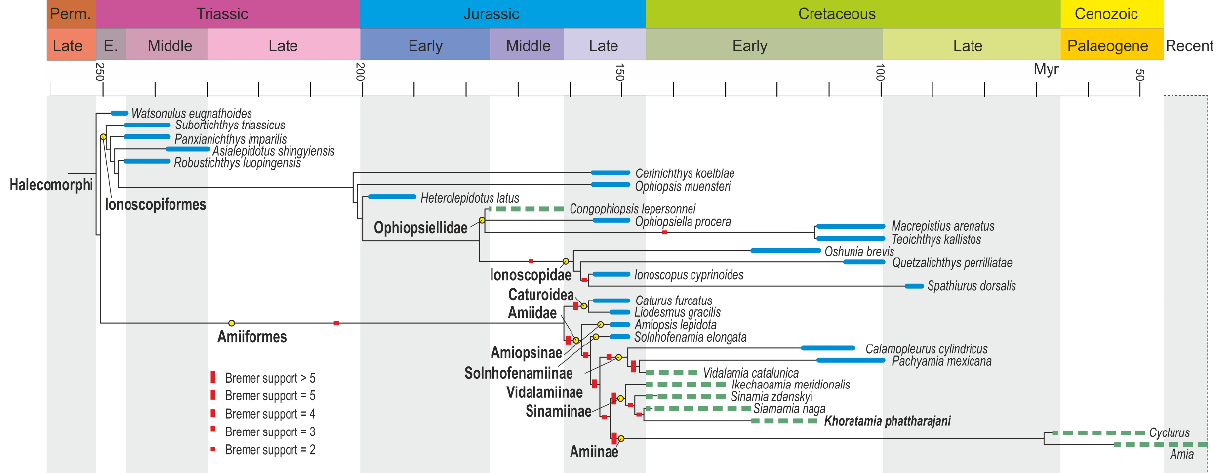
Figure 9. Strict consensus tree of the three most parsimonious trees: 258 steps; consistency index (CI) equals 0.4961; retention index (RI) equals 0.7368; and rescaled consistency index (RC) equals 0.3656. Stratigraphic ranges of marine taxa are shown in blue; green dotted lines indicate the stratigraphic ranges of continental taxa.